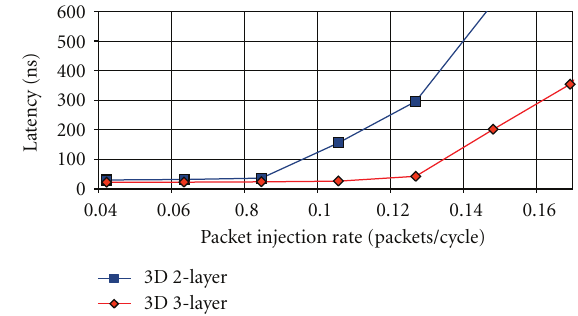
Figure 24: Latency for 2-layer and 3-layer implementations of xerox .